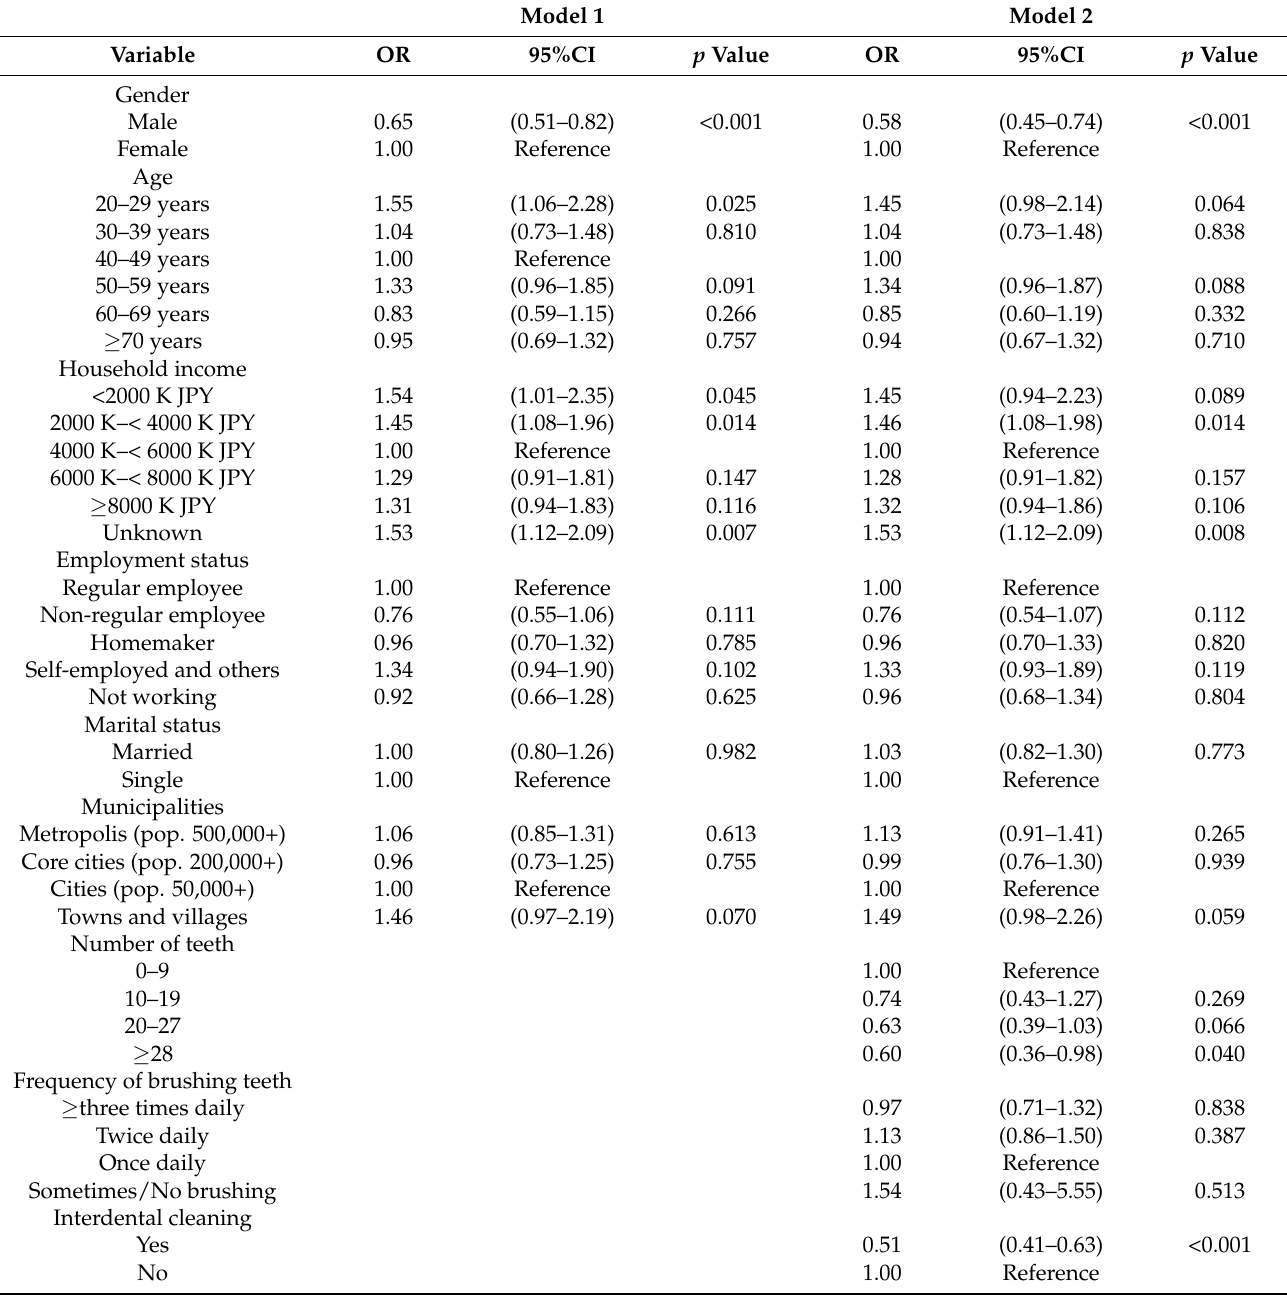
Table 2. Characteristics of those who have not received RDCs since the COVID-19 pandemic, despite habitually receiving RDCs before the